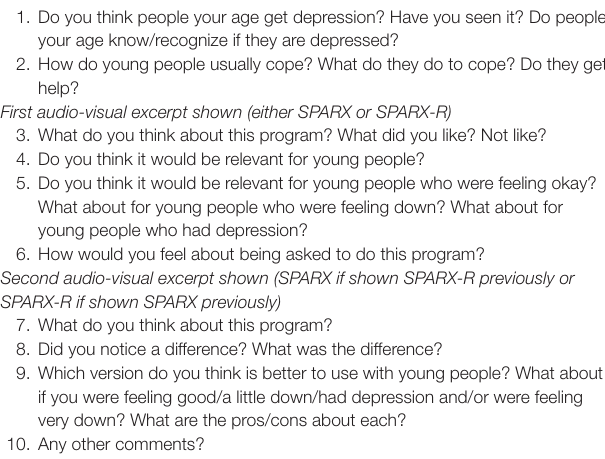
TABle 2 | Questions used to guide focus group